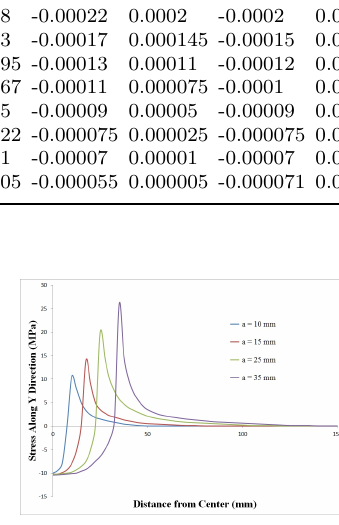
Figure 8. Evolution of σ x at different crack lengths.